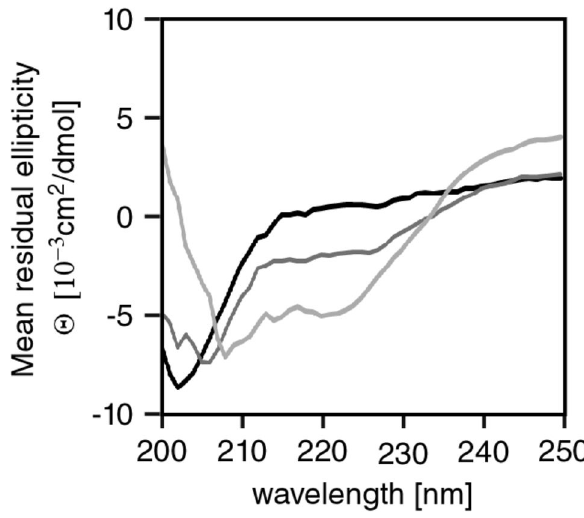
Figure 3. MCR lacks secondary structure. Far-UV CD spectra of APC-MCR in the absence (black) and presence of TFE (dark grey, 20%; light grey, 80%) in 10 mM Na-phosphate buffer (pH 7.2), 50 mM NaF, and 0.5 mM TCEP.